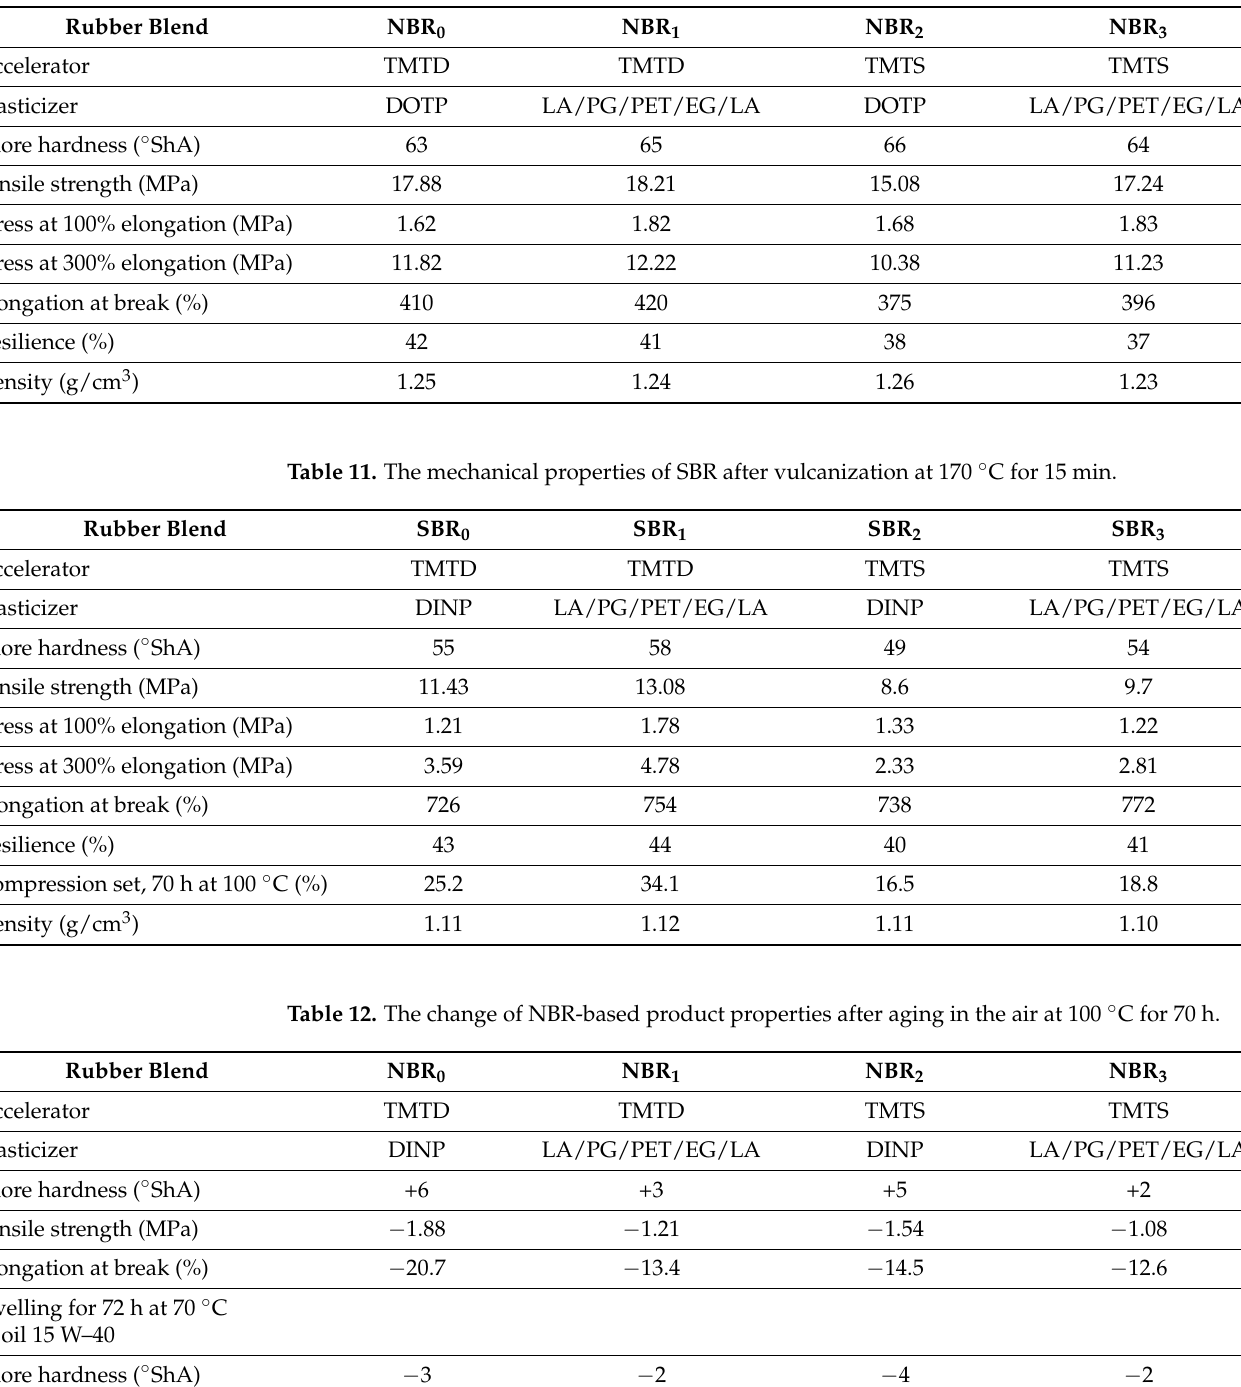
Table 10. The mechanical properties of NBR after vulcanization at 150 ◦ C for 15 min.